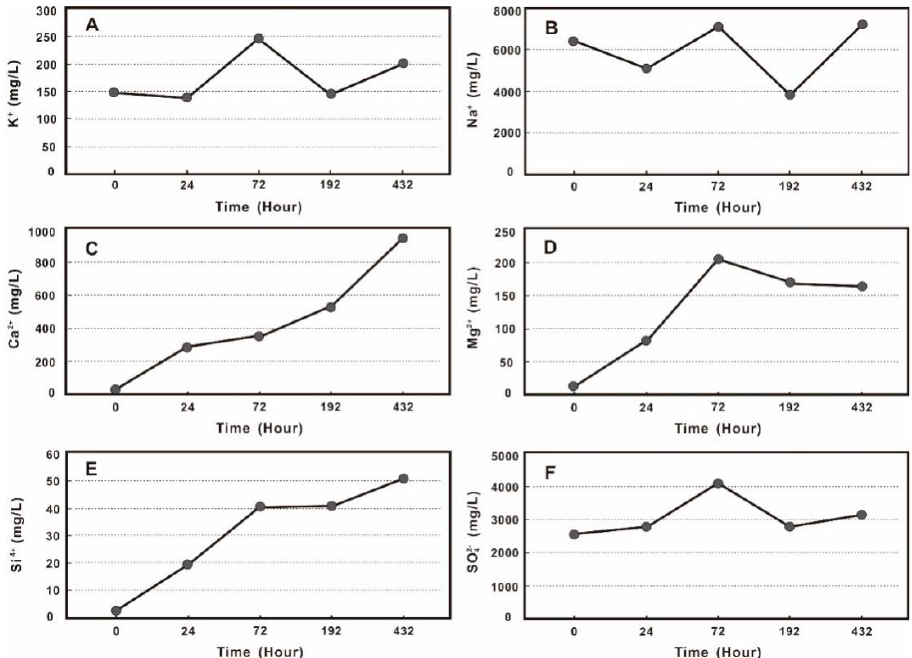
Figure 4. The changes of typical ions during the experiments ( A —K + ; B —Na + ; C —Ca 2+ ; D —Mg 2+ ; E —Si 4+ ; F —SO 42 − ).